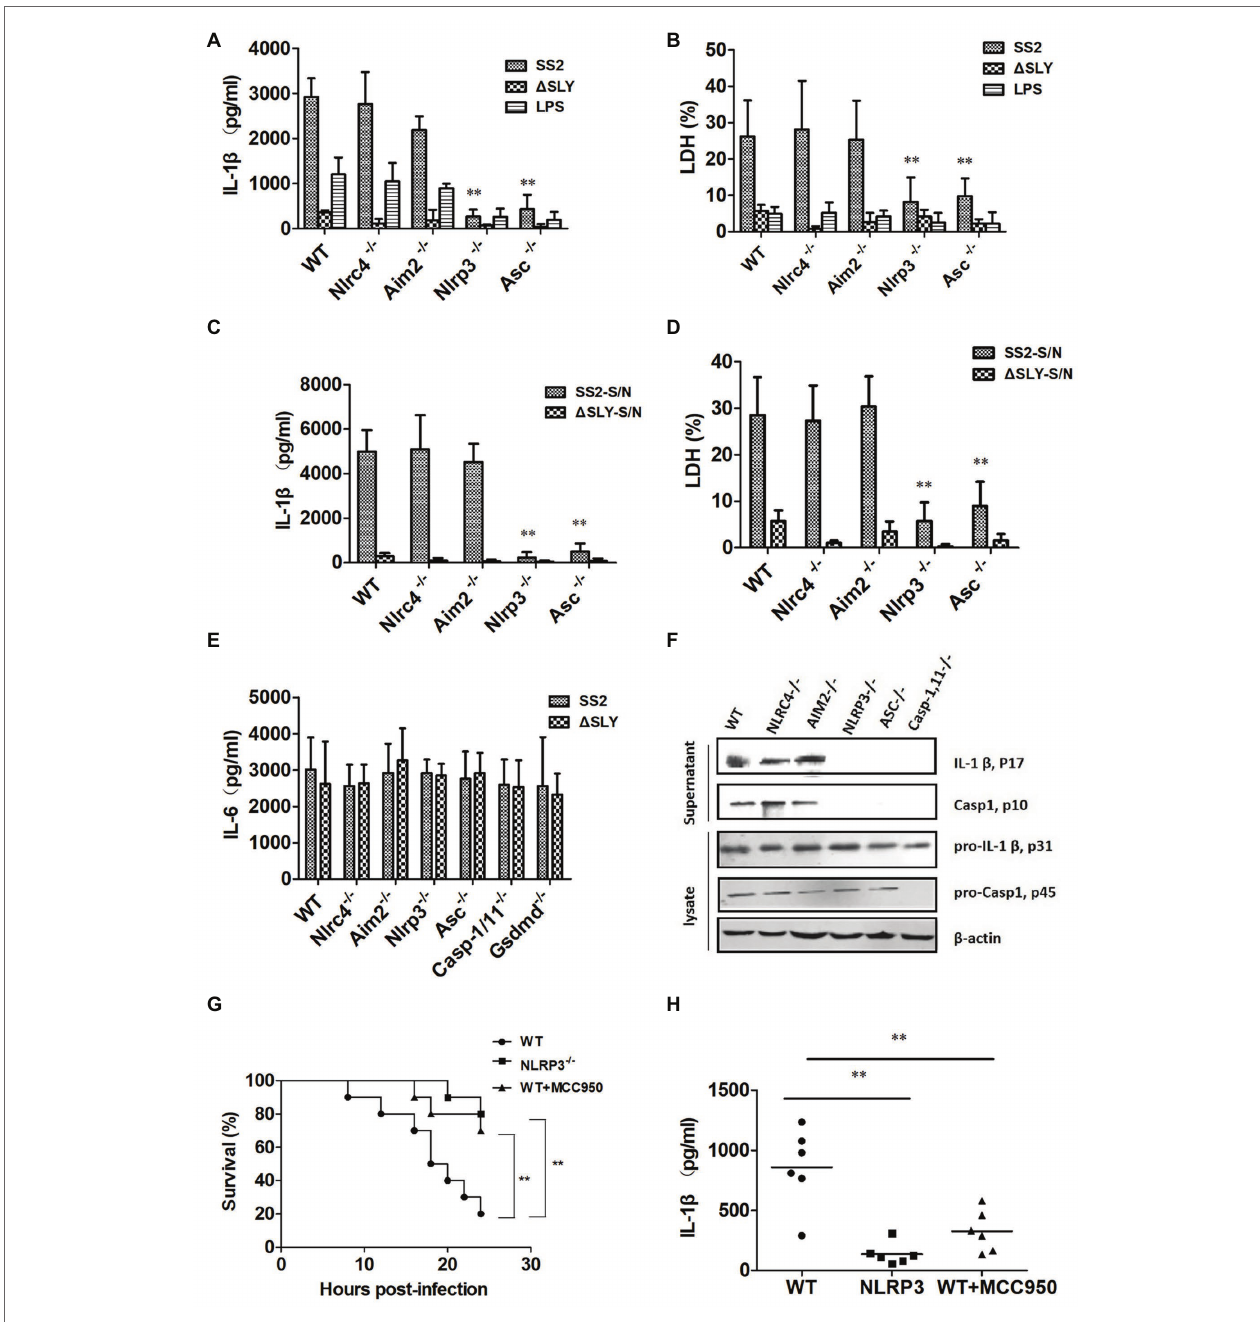
FIGURE 4 | The SS2-induced IL-1 β secretion is dependent on the Nlrp3 inflammasome activation in vitro and in vivo . BMDMs were isolated from WT C57BL/6J mice and multiple deficient mice [ Nlrc4 -deficient (Nlrc4 −/− ), Aim2 -deficient (Aim2 −/− ), Nlrp3 -deficient (Nlrp3 −/− ), and Asc -deficient (Asc −/− )] and infected with SS2 (MOI, 1) and ∆ SLY (MOI, 1) for 16 h. The supernatants were harvested and assayed for IL-1 β (A) , LDH (B) , and IL-6 (E) . These cells were also treated parallel with SS2-S/N (200 ng/ml) and ∆ SLY-S/N (200 ng/ml) for 16 h after LPS priming for 3 h. Their supernatants were collected for IL-1 β ELISA (C) and LDH assays (D) . (F) Along with immunoblotting, the supernatants were also measured for IL-1 β p17 and Caspase1 p10, and the cell lysates were analyzed for pro-IL-1 β p31 and pro-Caspase1 p45. (G) Three groups of 8-week-old mice, including WT mice (C57BL/6J), Nlrp3 −/− mice, and WT mice treated with the Nlrp3 inhibitor MCC950 (the WT mice were injected IP with Nlrp3 inhibitor MCC950 prior to SS2 infection), were injected IP with a higher dose of SS2 (2 × 10 9 CFU in 200 μ l PBS), and their survival was monitored for 24 h, with 10 mice per group. The WT mice infected with SS2 were considered as the positive control group. (H) Three groups of the abovementioned mice were injected IP with a lower dose of SS2 (2 × 10 8 CFU in 200 μ l PBS). The WT mice infected with SS2 were considered as the positive control group. These mice were sacrificed 24 h after injection and their PLF was harvested and measured for IL-1 β (six mice in each group). The data in panels (A–E) are the means ± standard deviations from three independent experiments. The data in panels (F–H) are obtained from one of two independent experiments. * p < 0.05; ** p <